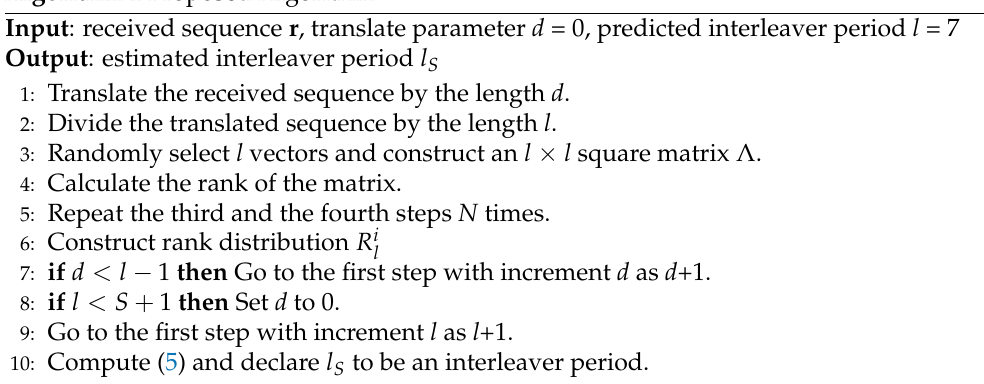
Algorithm 1 Proposed